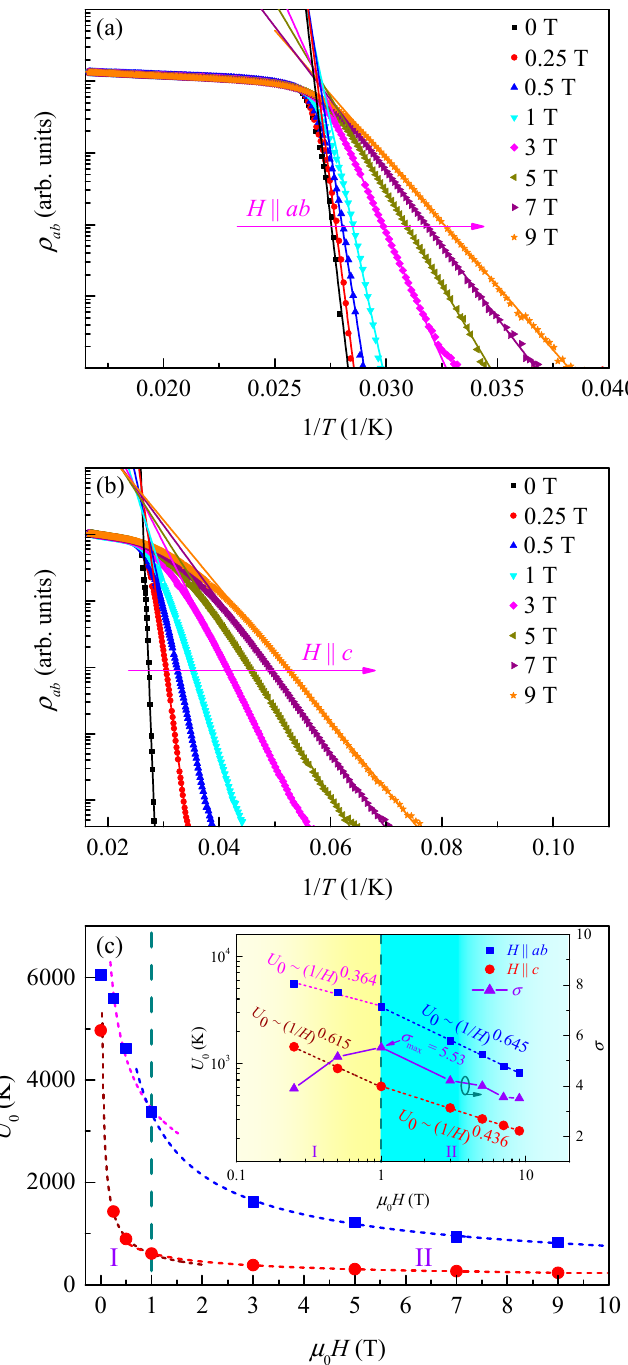
Figure 14. Arrhenius plot of ρ ab for ( a ) H || ab and ( b ) H || c . ( c ) μ 0 H dependence of U 0 and σ . Inset of ( c ) shows the same data on a double-logarithmic scale.